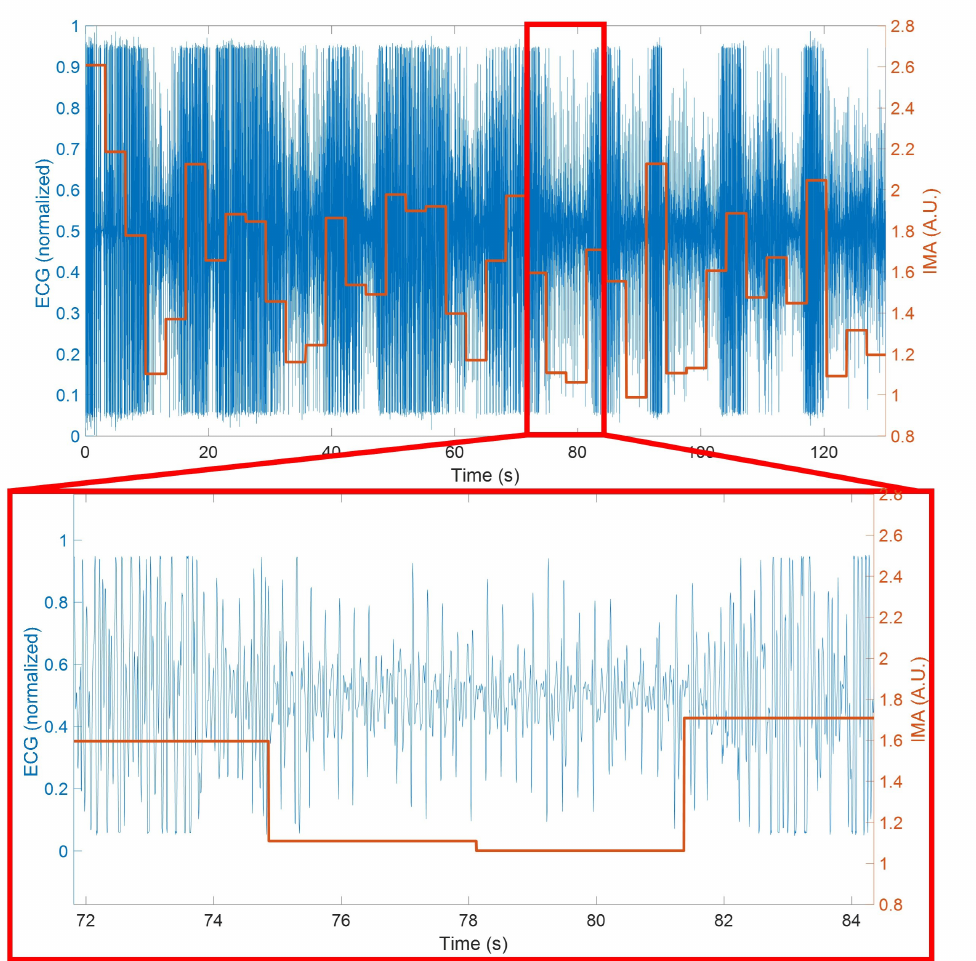
Figure 5. Process of heart rate estimation using adaptive filtering. The areas regions of ECG (blue) corresponding to lower IMA (orange) are used to estimate the overall heart rate and areas of higher IMA are